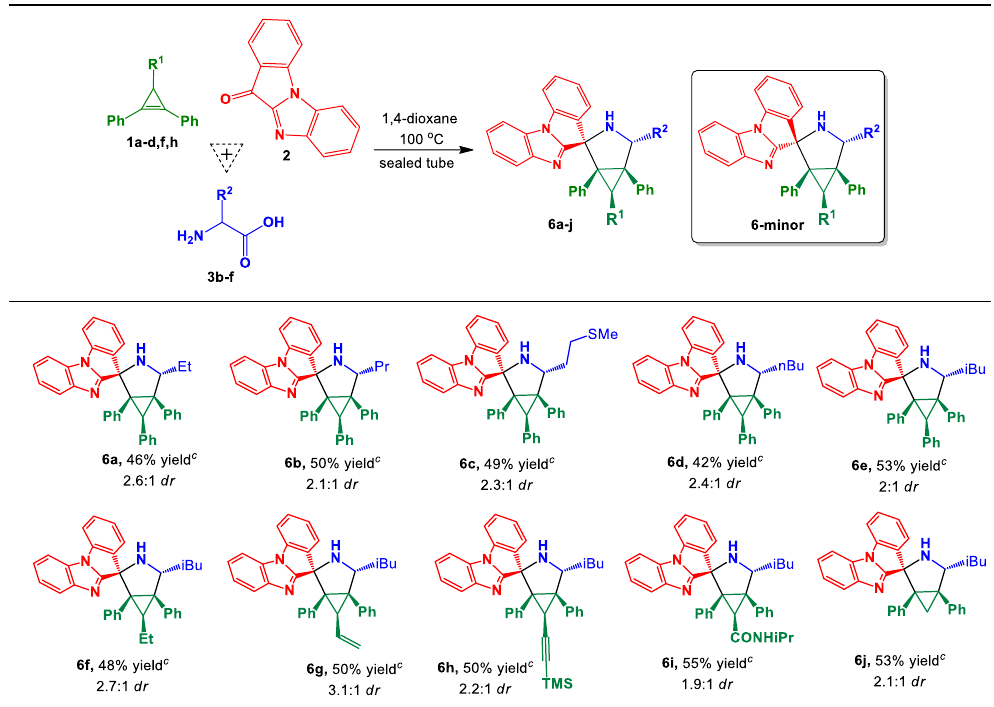
Table 3. Synthesis of Racemic Spiro-Adducts 6 via One-Pot Three-Component Reactions of Cyclo- propenes 1a-d,f,h, Ketone 2 and Primary α -Amino Acids 3b–f a,b,c,d.